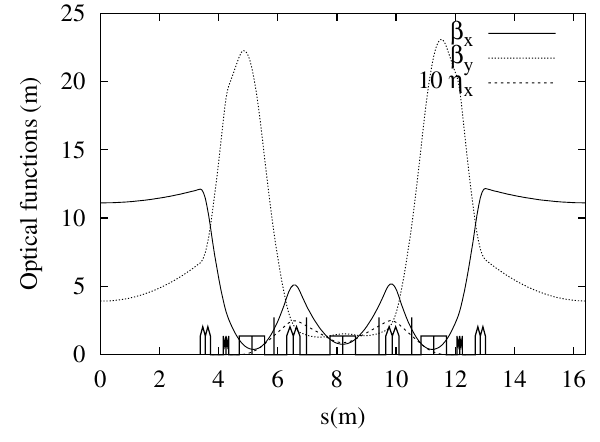
FIG. 15. One of the 12 ALS TBA